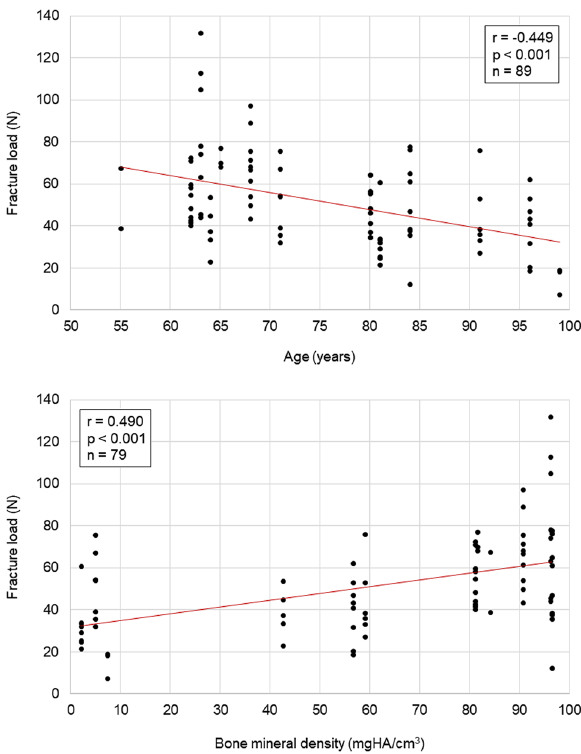
Figure 1. Scatter diagrams illustrating the effects of age (top) and bone mineral density (bottom) on fracture load. Trend lines are depicted in